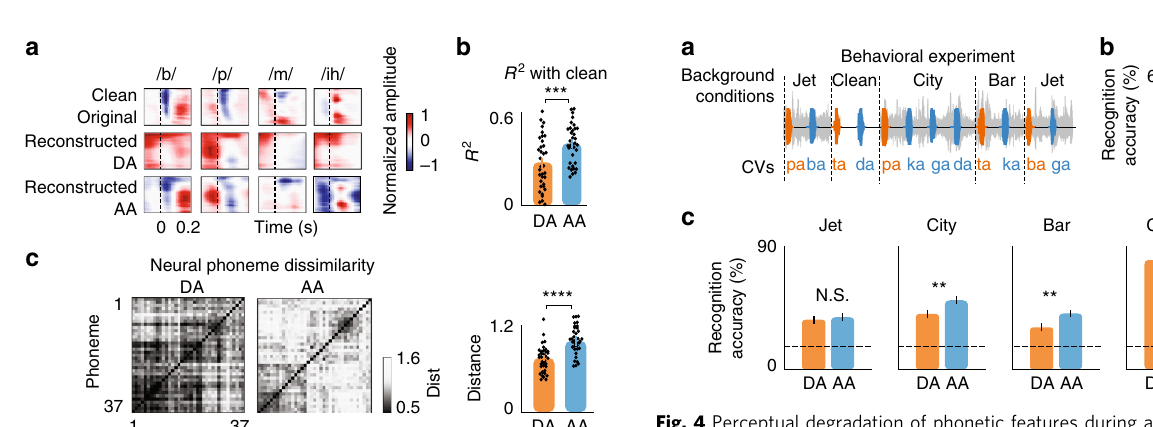
Fig. 4 Perceptual degradation of phonetic features during adaptation. a Behavioral experiment designed to test the intelligibility of consonant- vowel pairs occurring during adaptation (DA, orange) and after adaptation (AA, blue) intervals. Six consonant vowels (/pa,ta,ka,ba,da,ga/) were added to the same background noise used in the main task (Fig. 1b). Half of the CVs were uttered during adaptation (DA), and the other half were uttered after adaptation (AA). b Comparison of correctly recognized phonemes occurring during adaptation (DA) and after adaptation (AA) intervals (mean ± s.e.m. across CVs, N = 1068, ** Yate ’ s corrected chi- square test, p < 0.01). c Comparison of correctly recognized phonemes occurring during adaptation (DA) and after adaptation (AA) intervals for each condition separately (mean±s.e.m., N = 267, ** Yate ’ s corrected chi- square test, p < 0.05)